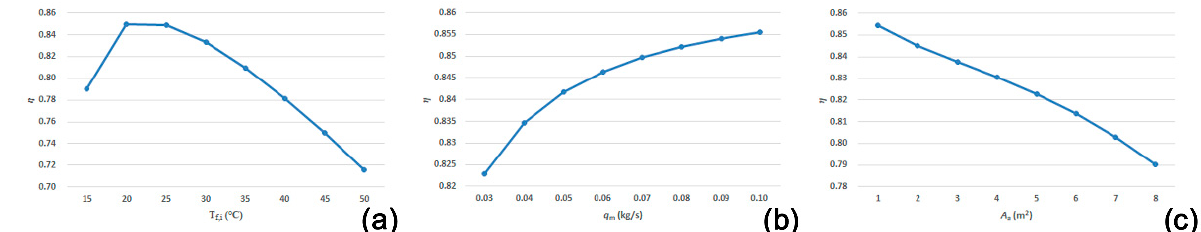
Figure 19. Influence of system situations. ( a ) Dependence between T f,i , and η . ( b ) Dependence between q m , and η . ( c ) Dependence between A a , and η .